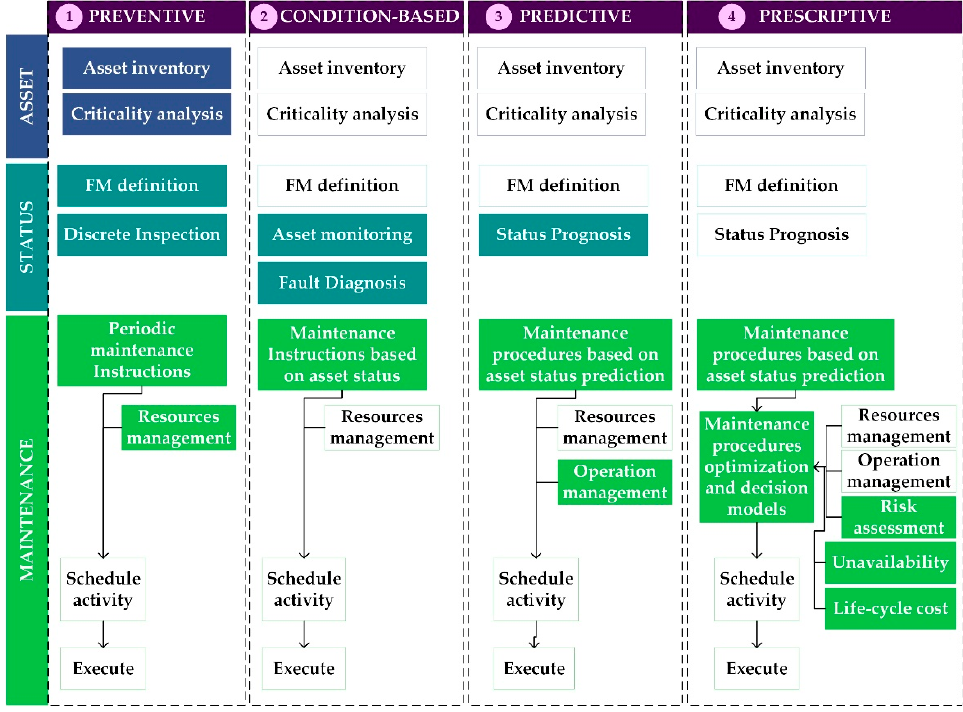
Figure 4. M3: Maintenance Maturity Model.